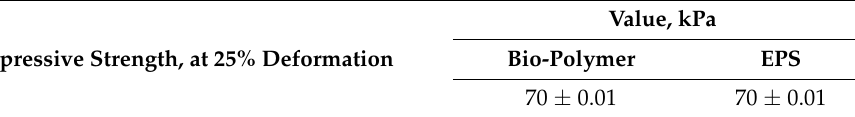
Table 3. Compressive strength of bio-polymer composite in comparison with commercial